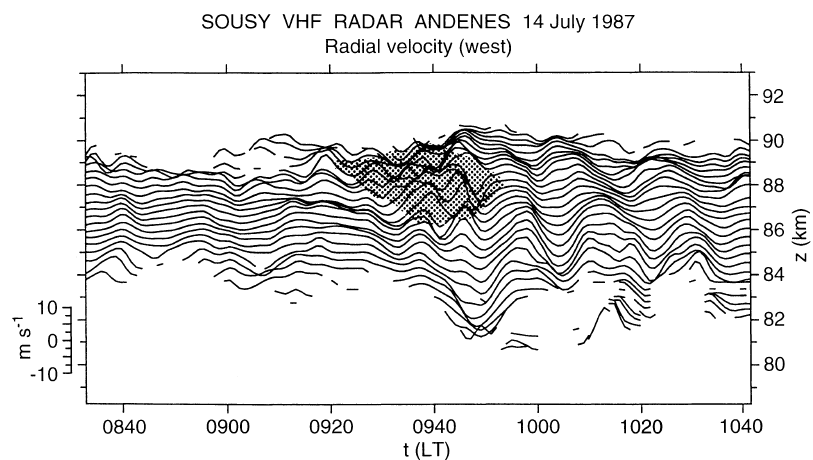
Fig. 8. Radial velocities versus time observed with a westward pointing beam. The stippled area denotes the extent of the structure of enhanced turbulence